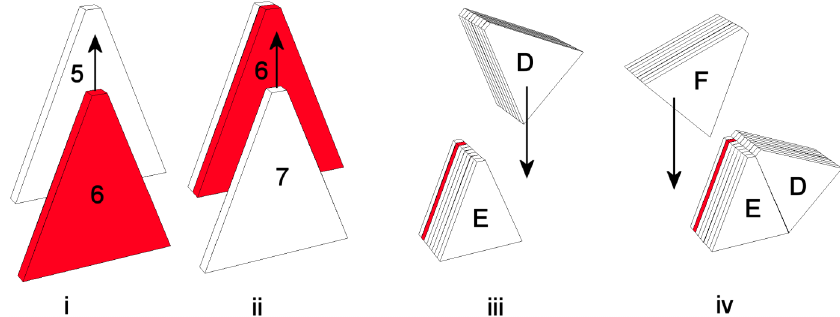
FIG. 13. (Color) The maximum reverse field in the red block was calculated as it is assembled into a wedge (i), as the rest of the blocks in the wedge are added (not all blocks are shown) (ii), and as the two adjacent wedges are added (iii and iv). The block numbers and wedge letters are determined from Fig.